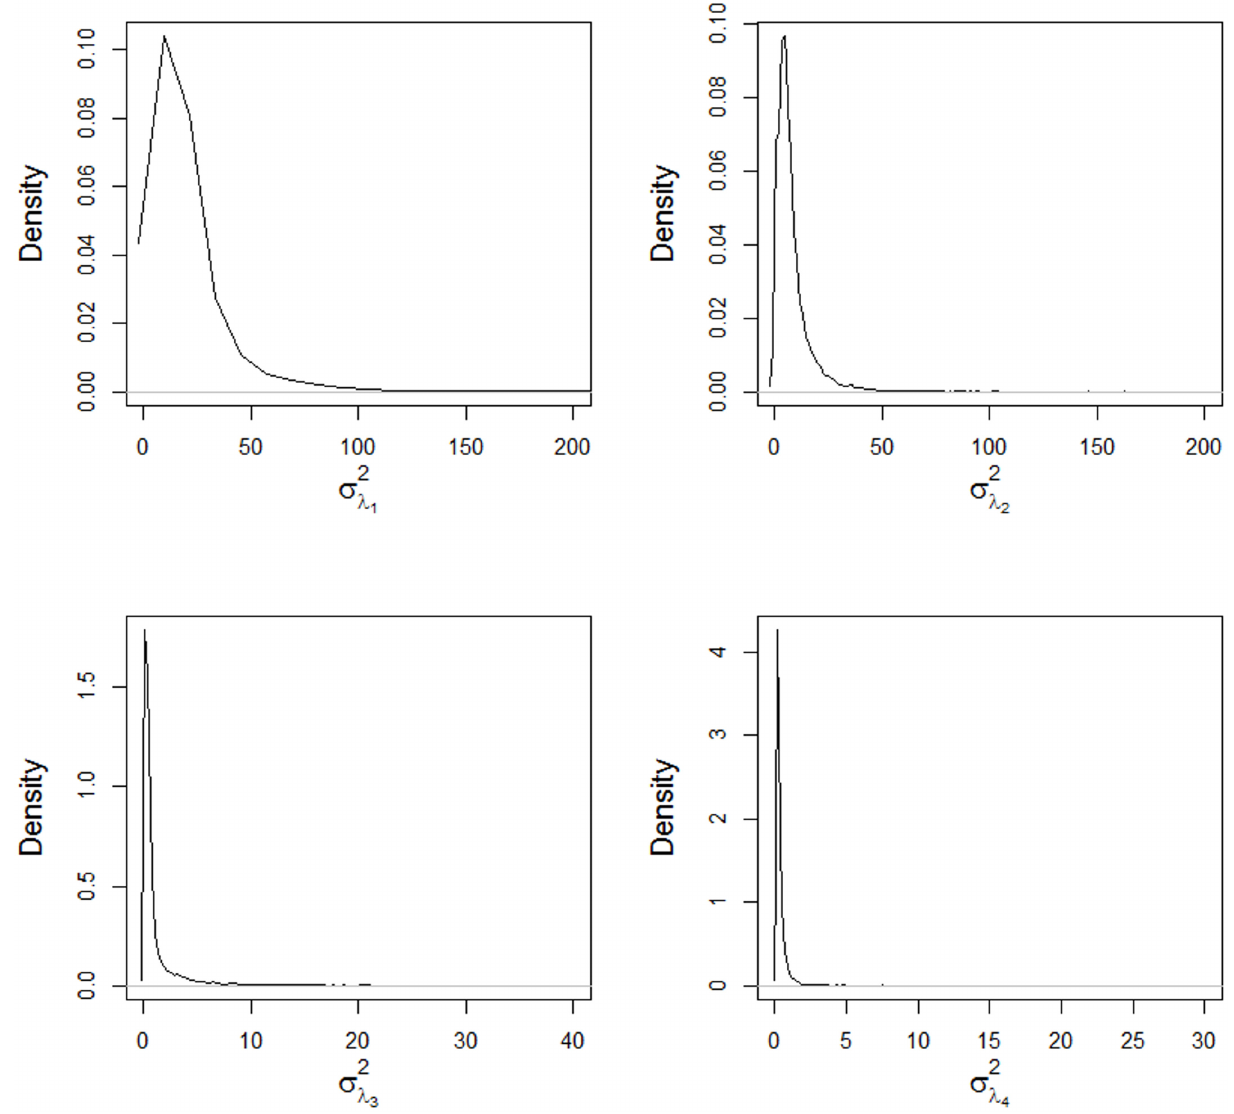
; σ 2 ; σ 2 σ 2 λ 2 λ 3 and λ 4 , obtained using the AMMIBS 1